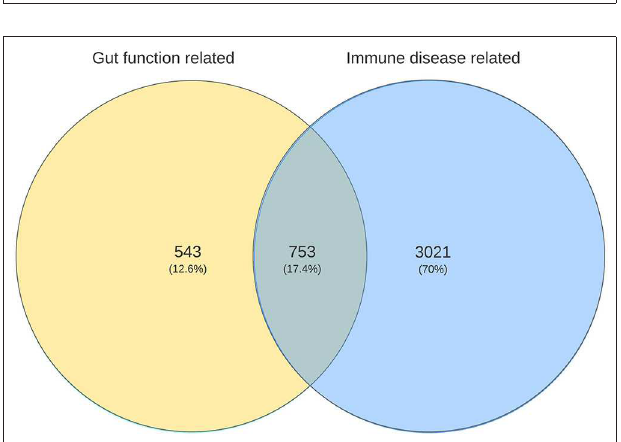
FIGURE 3 | Venn diagram illustrating the numbers of unique and shared genes related to gut functions with immune disease related genes.